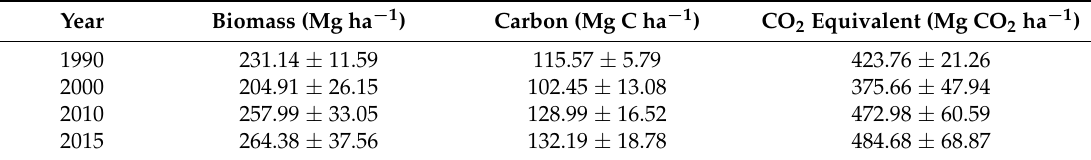
Table 3. Baseline values of biomass, carbon and equivalents for the calculation of emissions (including standard error or the mean).